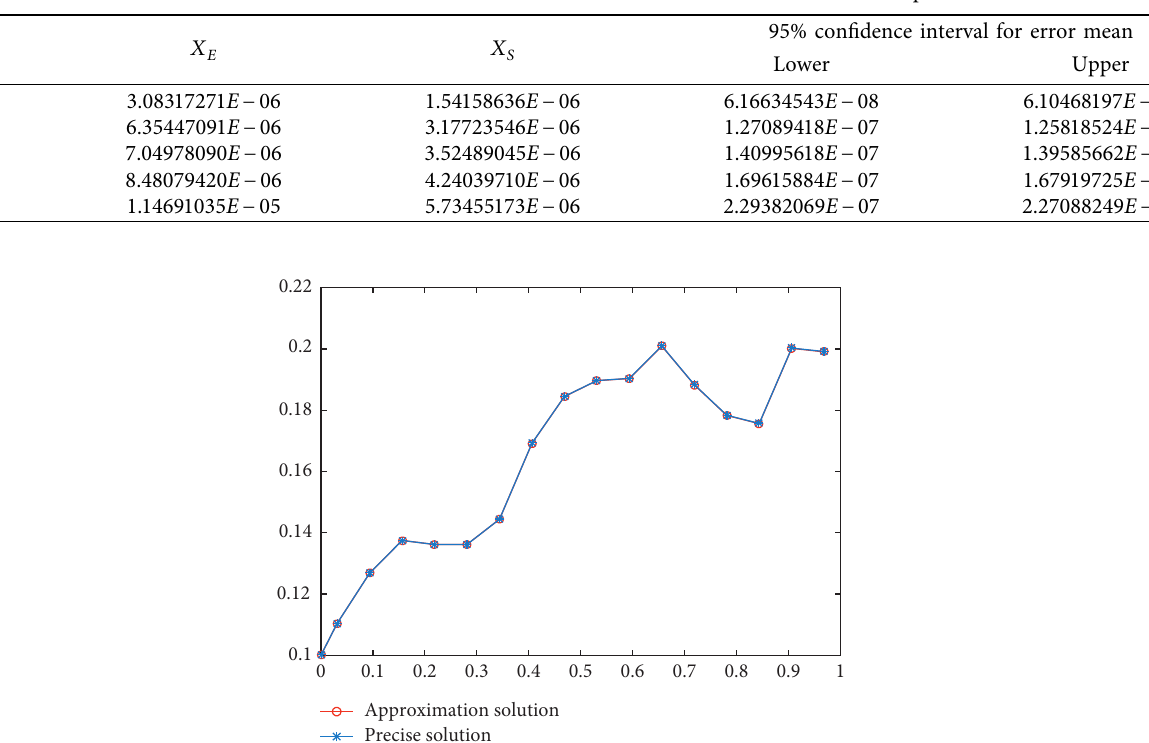
Table 4: When m � 16 and H � 0 . 8, the table exhibits numerical results of Example 2.